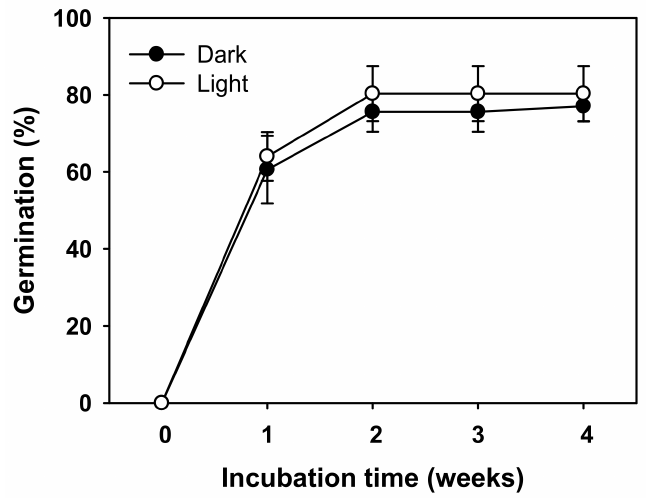
Figure 7. Germination of V. sibiricum seeds as affected by light after cold stratification at 4 ◦ C for 2 weeks. Seeds were incubated at 20/10 ◦ C (12/12 h) after cold stratification. Error bars represent mean ± SE of four